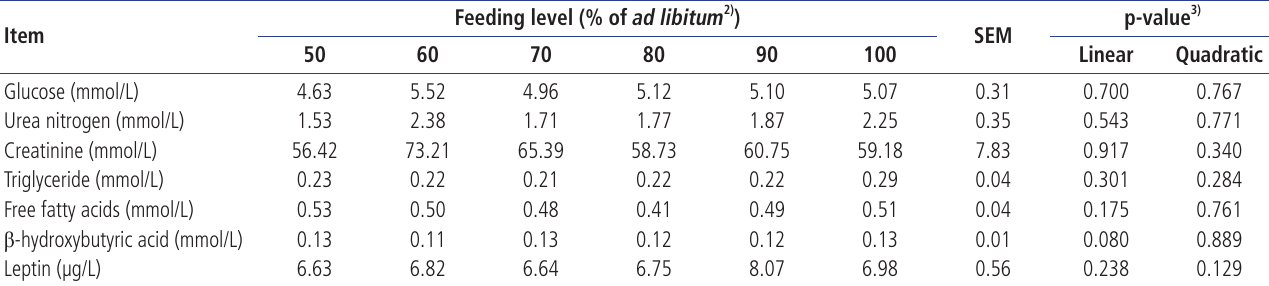
Table 4. Effects of feeding level on the concentration of serum biochemical parameters in growing pigs 1) Item